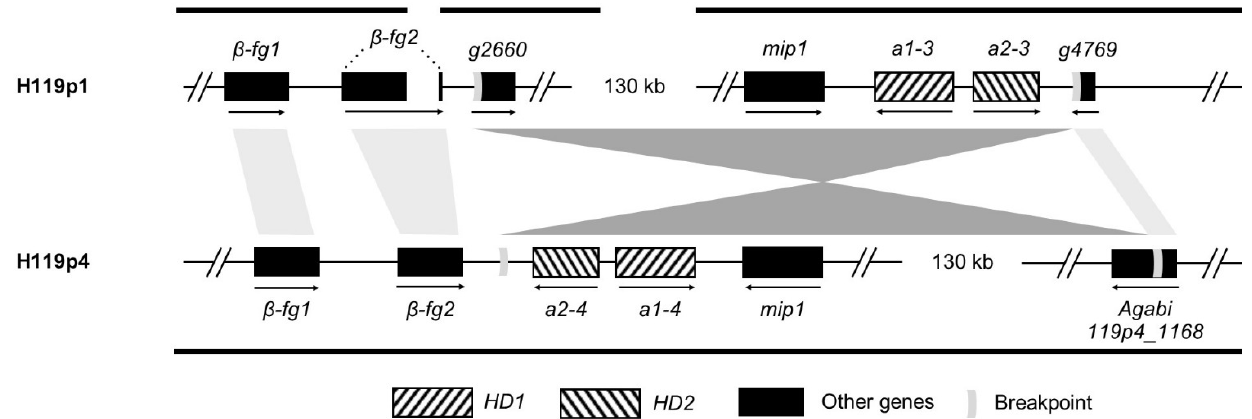
Figure 9. Identity and organization of mating-type genes in the A. bisporus var. burnettii 119/9 genome. The two constitutive homokaryon genomes (i.e., H119p1 and H119p4) are shown in the top and bottom, respectively. Homeodomain ( HD ) genes are shown with striped boxes, and flanking β -fg and mip1 genes are shown with solid black boxes. Orthologous gene pairs are linked with grey shaded rectangles. The mating-type genes as well as flanking genes are found in three distinct contigs in the homokaryon H119p1 genome (indicated by black bars, the β -fg2 gene being split onto two contigs), while they are all found ( β -fg genes in tandem) in one contig in the H119p4 genome. A ca. 140 kb-long inversion was identified between the two genomes of different mating types, figured by the pair of dark grey triangles. The inversion breakpoints are indicated by light grey symbols within the involved genes and non-coding DNA regions.